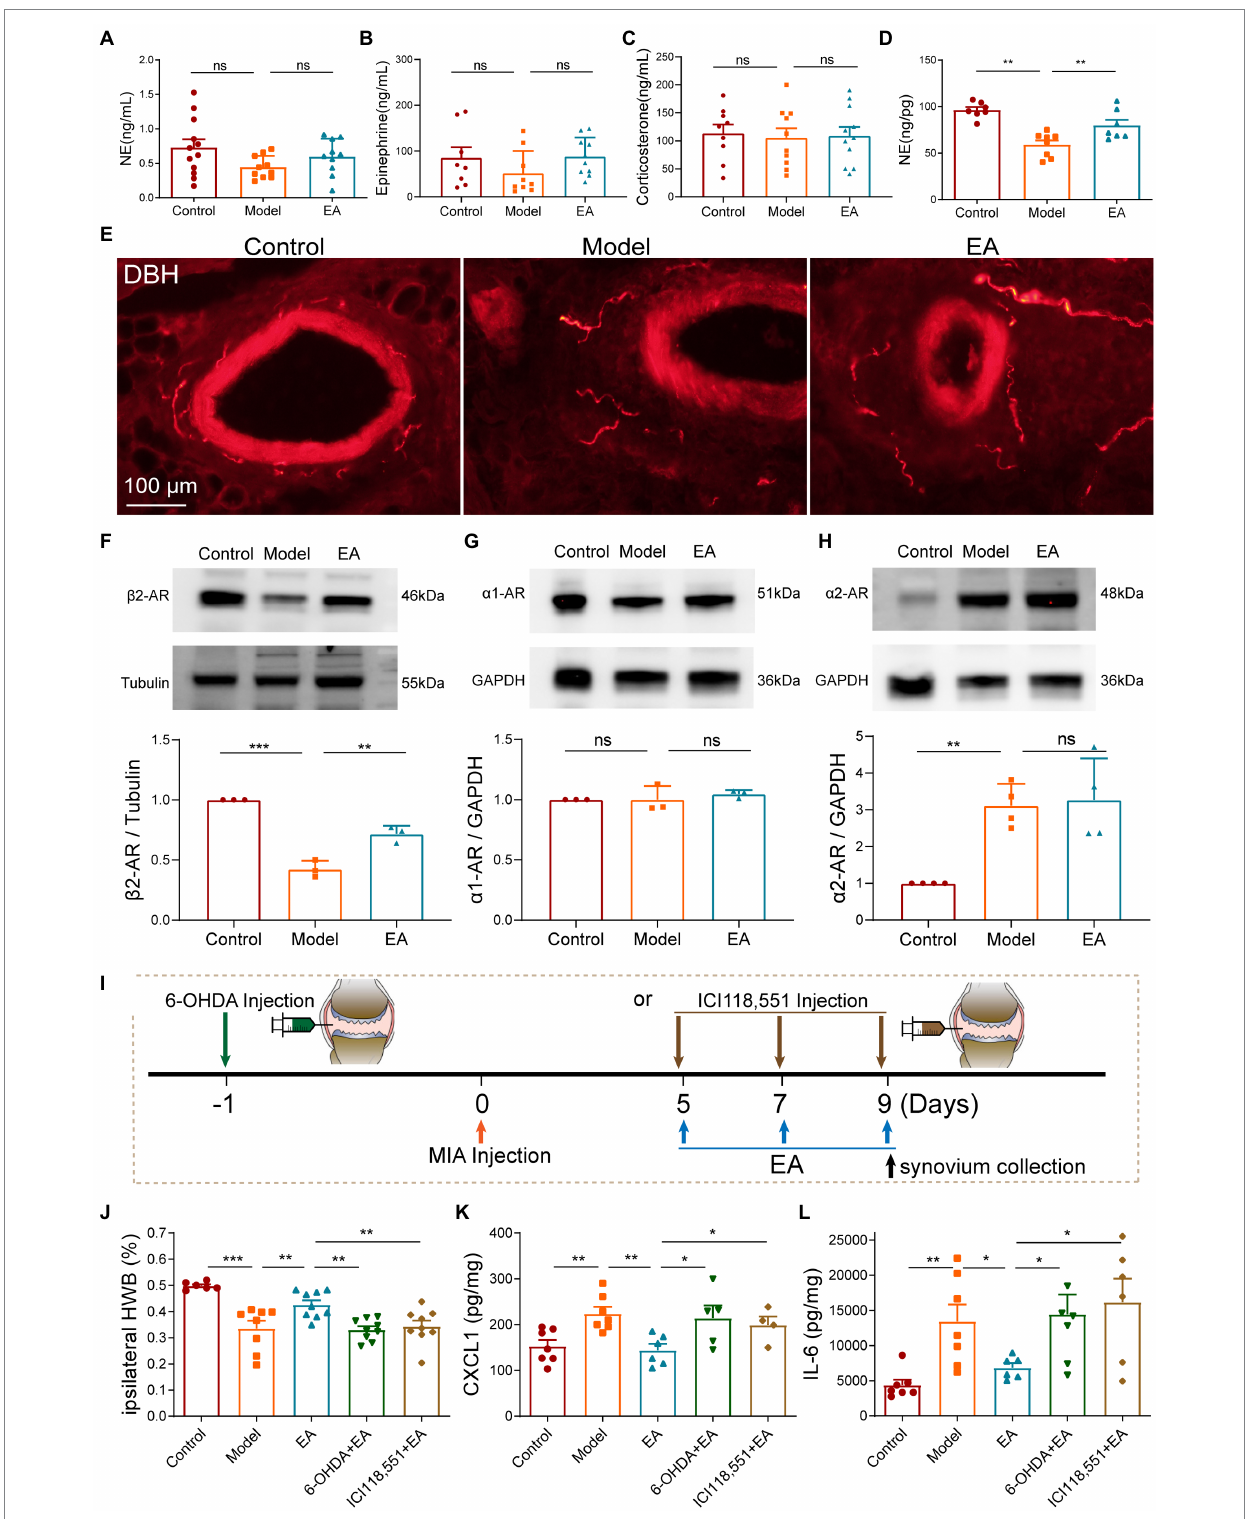
FIGURE 4 Midterm EA increased sympathetic nerve transmitters NE to suppress the levels of CXCL1 and IL-6 in the synovium in a β 2AR-dependent manner on day 9 after MIA injection. (A–C) No significant difference was observed in the levels of NE, epinephrine, and corticosterone in the plasma among the three groups ( n = 10– 12, * p < 0.05, ** p < 0.01, *** p < 0.001). (D) The levels of NE in the synovium were decreased in the model group in comparison with those of the control but were increased in the EA group ( n = 10, * p < 0.05, ** p < 0.01, *** p < 0.001). (E) Immunohistochemical staining of the synovium revealed that the expression of DBH- positive sympathetic nerve was decreased in the model group and was increased in the EA group ( n = 3). (F) The expression of β 2-AR in the synovium was decreased in the model group in comparison with the control but was increased in the EA group ( n = 3, * p < 0.05, ** p < 0.01, *** p < 0.001). (G) No significant difference was observed in the expression of α 1-AR in the synovium among the three groups ( n = 3, * p < 0.05, ** p < 0.01, *** p < 0.001). (H) The expression of α 2-AR in the synovium was increased in the model and EA groups, but there was no significant difference between that in the model group and the EA group ( n = 3, * p < 0.05, ** p < 0.01, *** p < 0.001). (I) Intra-articular injections of 6-OHDA and ICI 118,551 were performed to block neurotransmitters NE and its β 2-AR. (J) Intra-articular injection of 6-OHDA and ICI 118,551 blocked the protective effect of EA on the WBD. (K,L) Intra-articular injection of 6-OHDA and ICI 118,551 blocked EA-induced suppression of the levels of CXCL1 and IL-6 ( n = 8, * p < 0.05, ** p < 0.01, *** p <